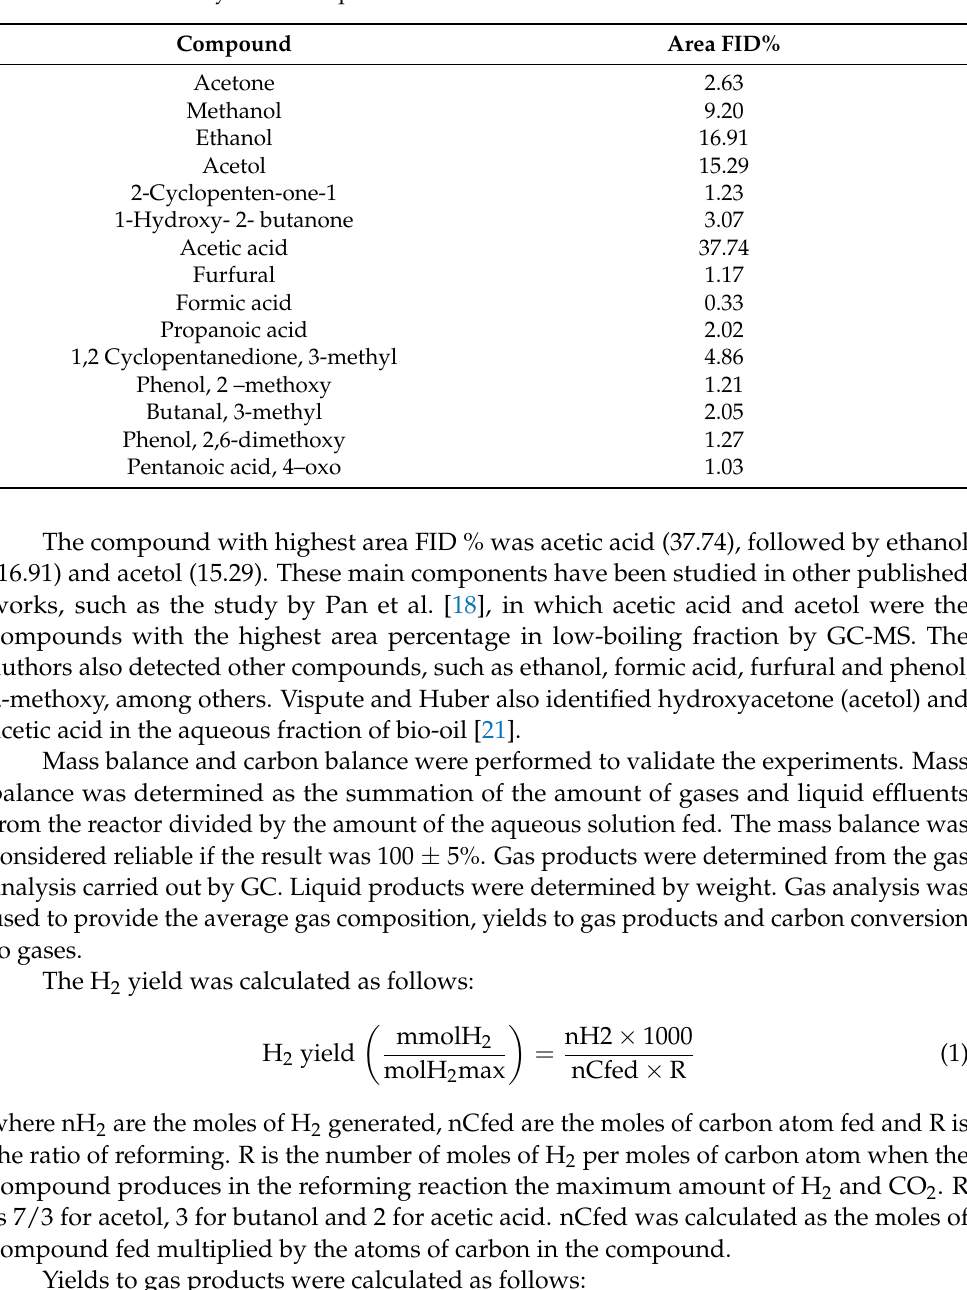
Table 1. Chemical analysis of the aqueous fraction of